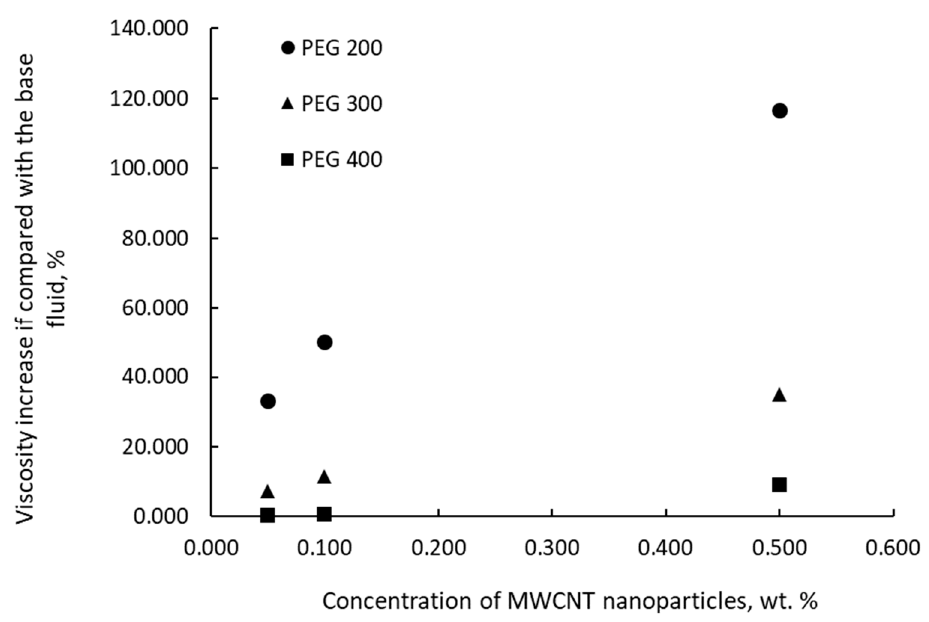
Figure 5. A comparison of adding MWCNTs to different PEG base fluids at 288.15 K.